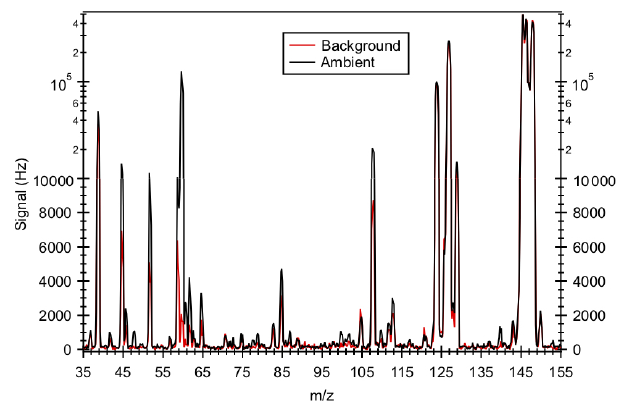
Figure 2. Mass spectrum of ambient air and background measured in Yorkville, Georgia, on 8 September 2016 using SF − the 32 SF − reagent ion signal (at m/z 146) is saturated, causing the 6 sharp drop in its signal. As a result, the ion signal of its isotope 34 SF − (at m/z 150) was monitored to determine if the reaction of 6 SF − with ambient water vapor and O 3 depleted SF − 6